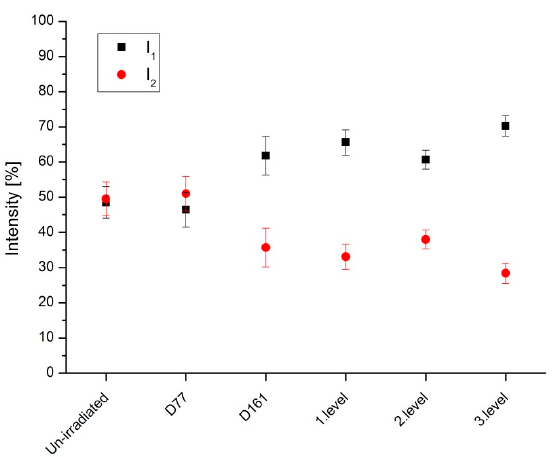
Figure 2. Intensity of positron lifetimes of all measured P370 WM specimens–unirradiated, neutron irradiated (D77 and D161) and 3 levels of H + ion irradiated.